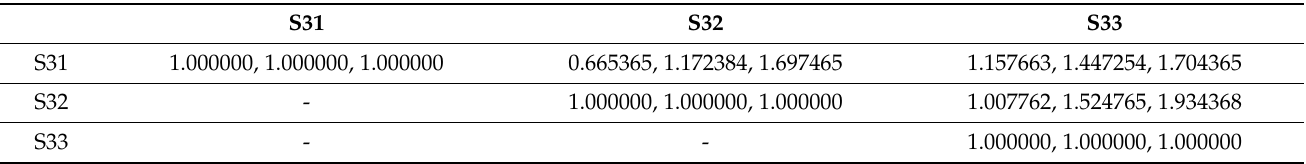
Table 4. The fuzzy-aggregated pairwise comparison matrix at Level 2 for business.